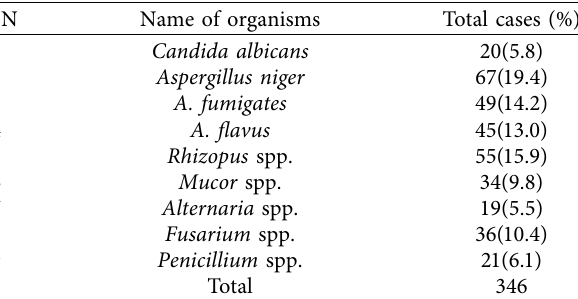
Table 2: Growth pattern of